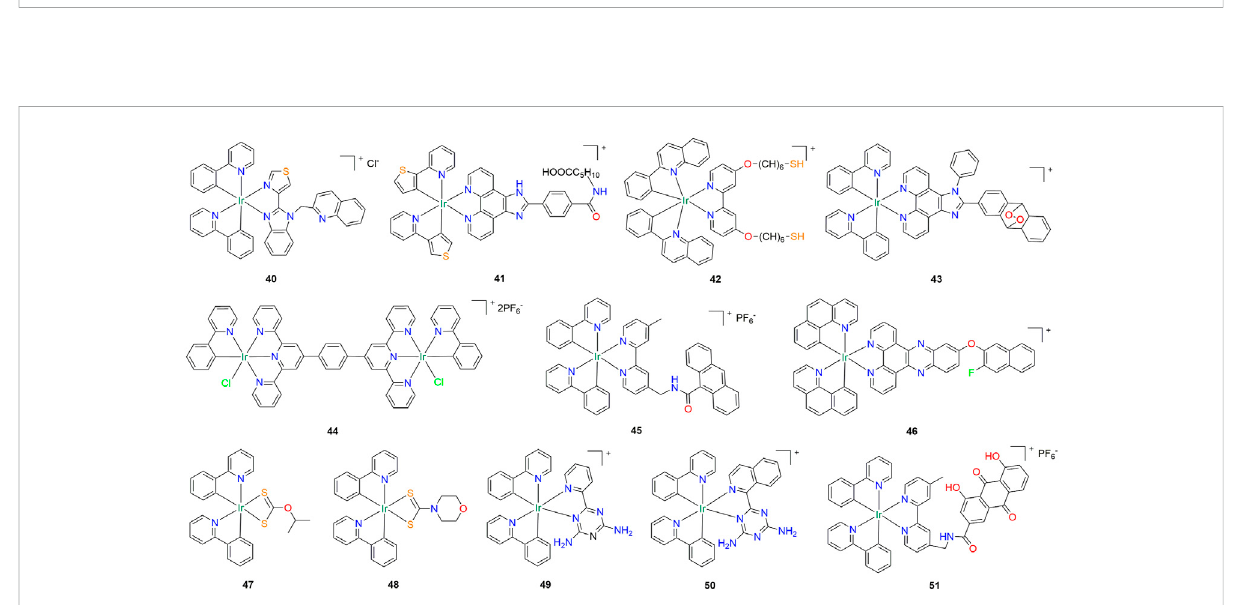
FIGURE 4 Structure of anti-lung cancer cyclometalated Iridium (III) compounds ( 40 – 51